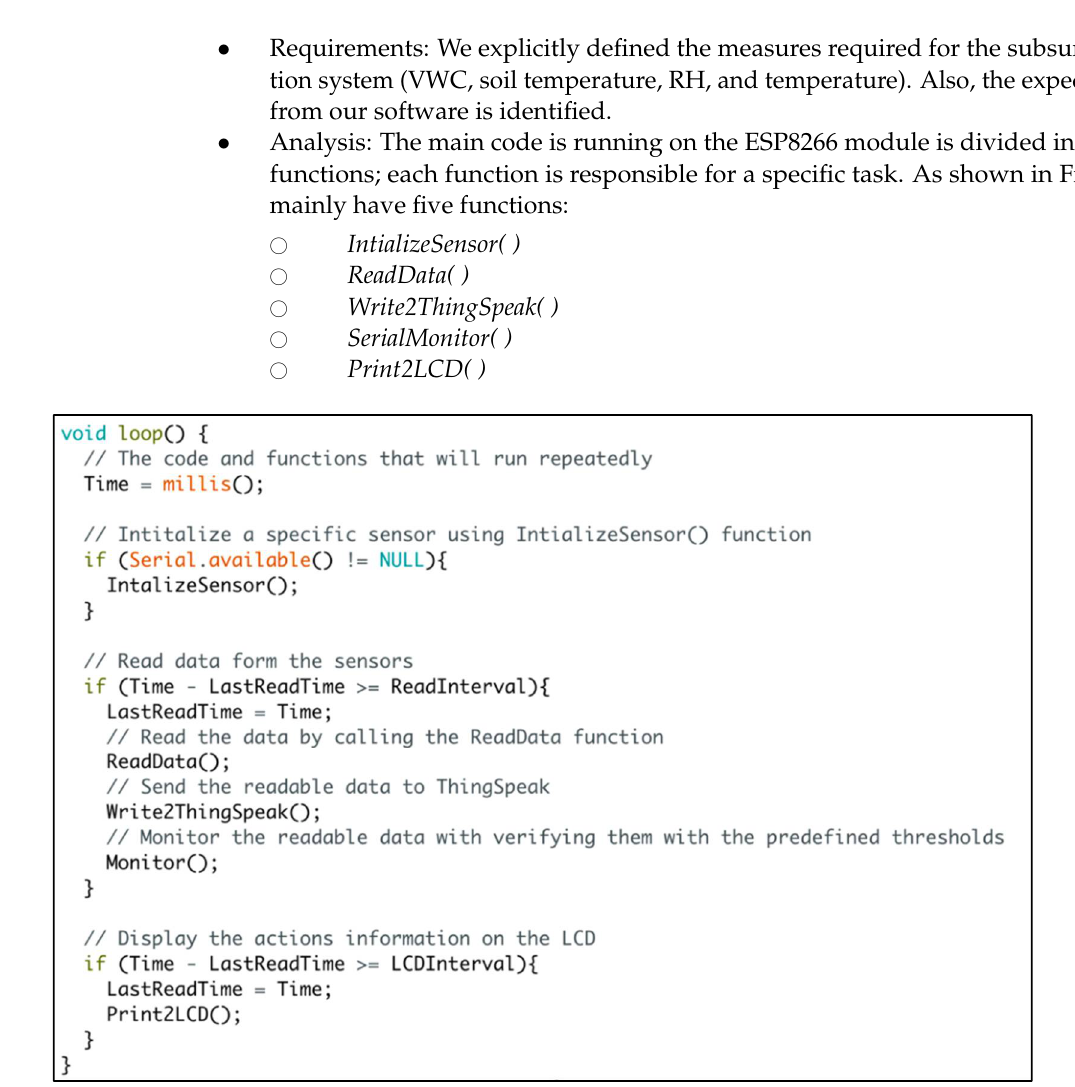
Figure 6. The repeatedly executed code on the ESP8266 NodeMCU board. Design: The data variables/objects and operations have been identified.